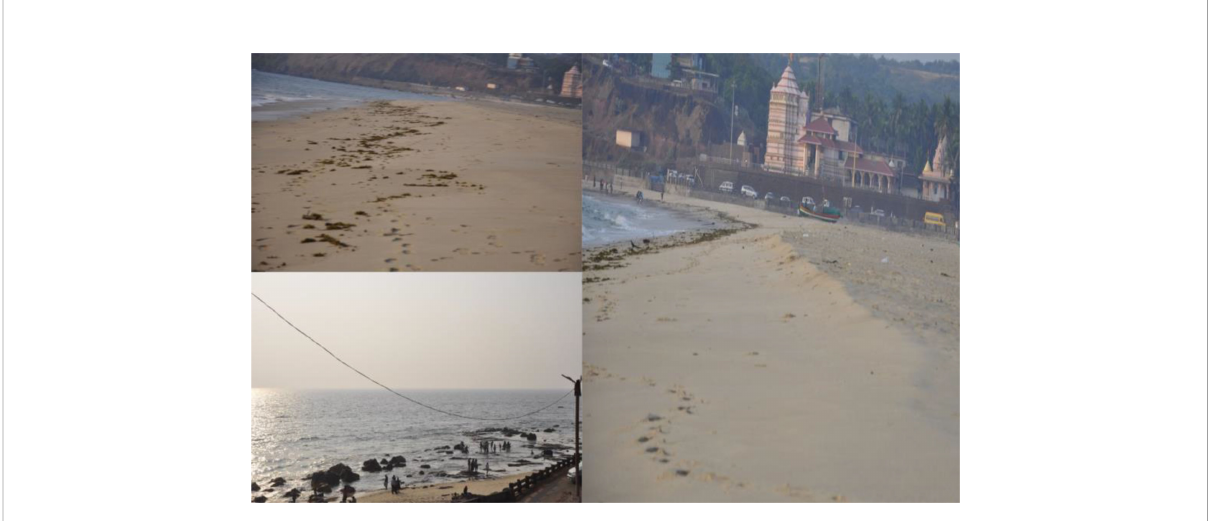
FIGURE 1 Plate no 1 Kunkeshwar location climate collection